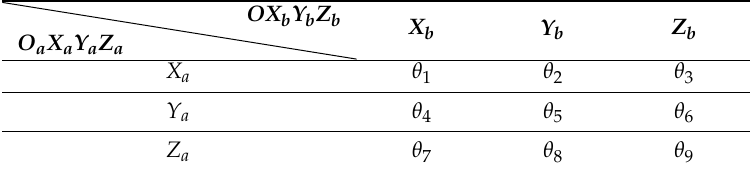
Table A1. Antenna coordinate system stand-alone angle fine measurement